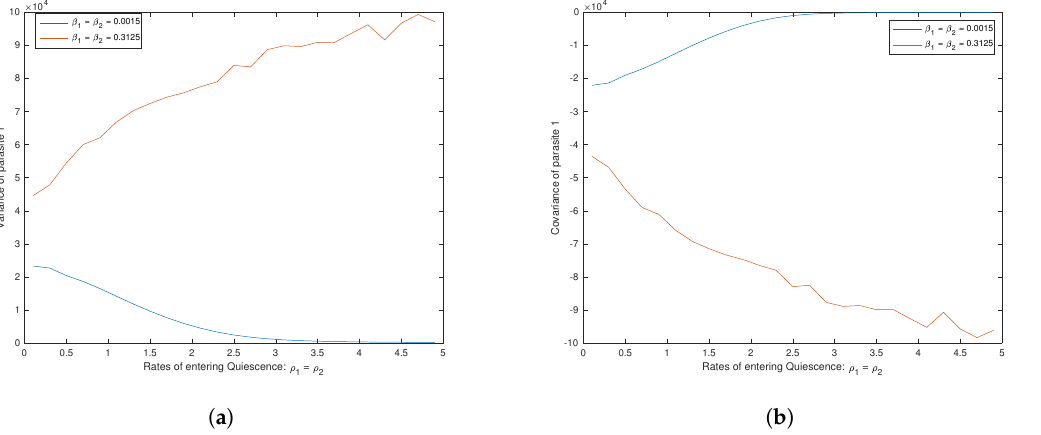
Figure 4. Effect of quiescence, rates of entering the quiescence phase ρ 1 = ρ 2 , and of transmission rates β 1 = β 2 on the ( a ) variance of parasite 1, and ( b ) covariance of parasite 1 of the collapsed covariance matrix. We use the following parameter values (symmetrical case): d = 0.5, Λ = 1000, ν 1 = ν 2 = 0.3, γ 1 = γ 2 = 0.003, ζ 1 = ζ 2 = 0.1, (cid:101) 1 = (cid:101) 2 = 10 and the initial population sizes are H = 50,000, I 1 = 10,000, I 2 = 10,000, Q 1 = 5000, Q 2 = 5000,time = 300. The blue line is for β 1 = β 2 =